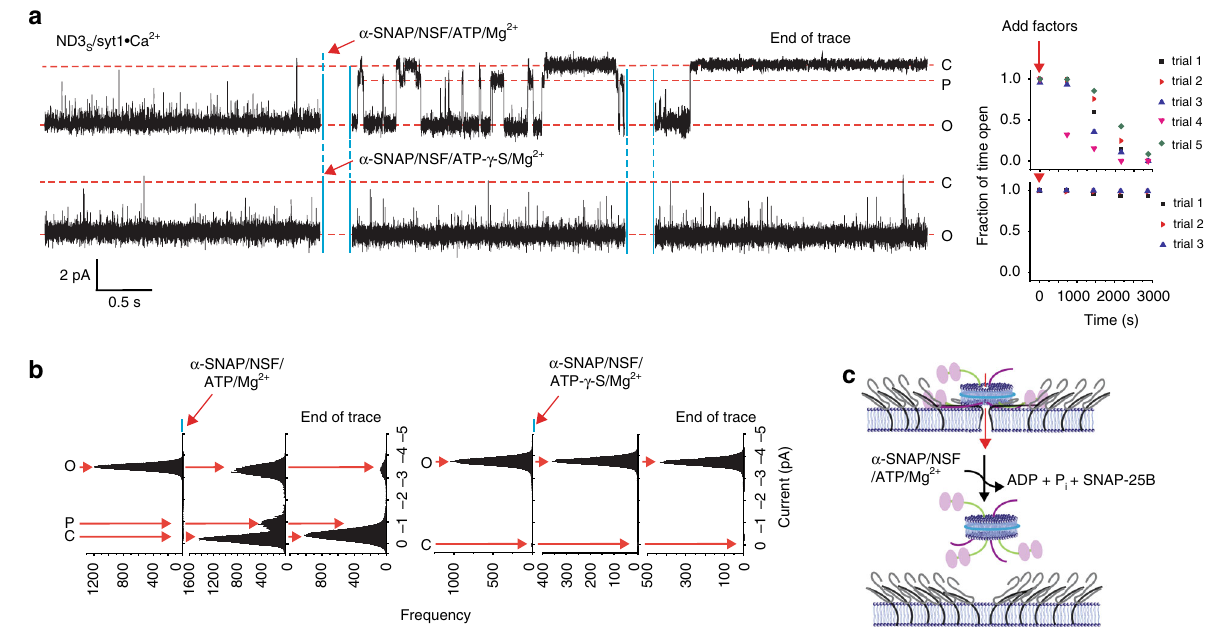
Fig. 6 α -SNAP/NSF-ATP disassemble trans -SNARE complexes formed by Ca 2 + (cid:129) syt1. a Representative recording of a pore formed by ND3 S /syt1 in 500 µ M [Ca 2 + ] µ M α -SNAP, 0.3 µ M NSF, 1 mM ATP, and 5 mM MgCl free . After pore formation, 0.3 2 were added (red arrow). In the lower panel, ATP was replaced with 1 mM ATP- γ -S. Two different epochs of each trace are shown; the time interval between each epoch is indicated. Closed (C), open (O), and partially open (P) states are marked; the current/time scale for all traces is provided in the inset. After addition of the disassembly factors, recordings were divided arbitrarily into fi ve 720-s epochs; the fraction of time the pores were open during each epoch was quanti fi ed for individual traces and plotted beside each panel. n = 5 BLMs using ATP, and n = 3 BLMs using ATP- γ -S; two different sets of NDs were used for each condition. b Representative current histograms for the experiments described above are shown. c Illustration (drawn to scale) shows the α -SNAP/NSF/ATP/Mg 2 + -mediated disassembly of SNAREs, leading to fusion pore